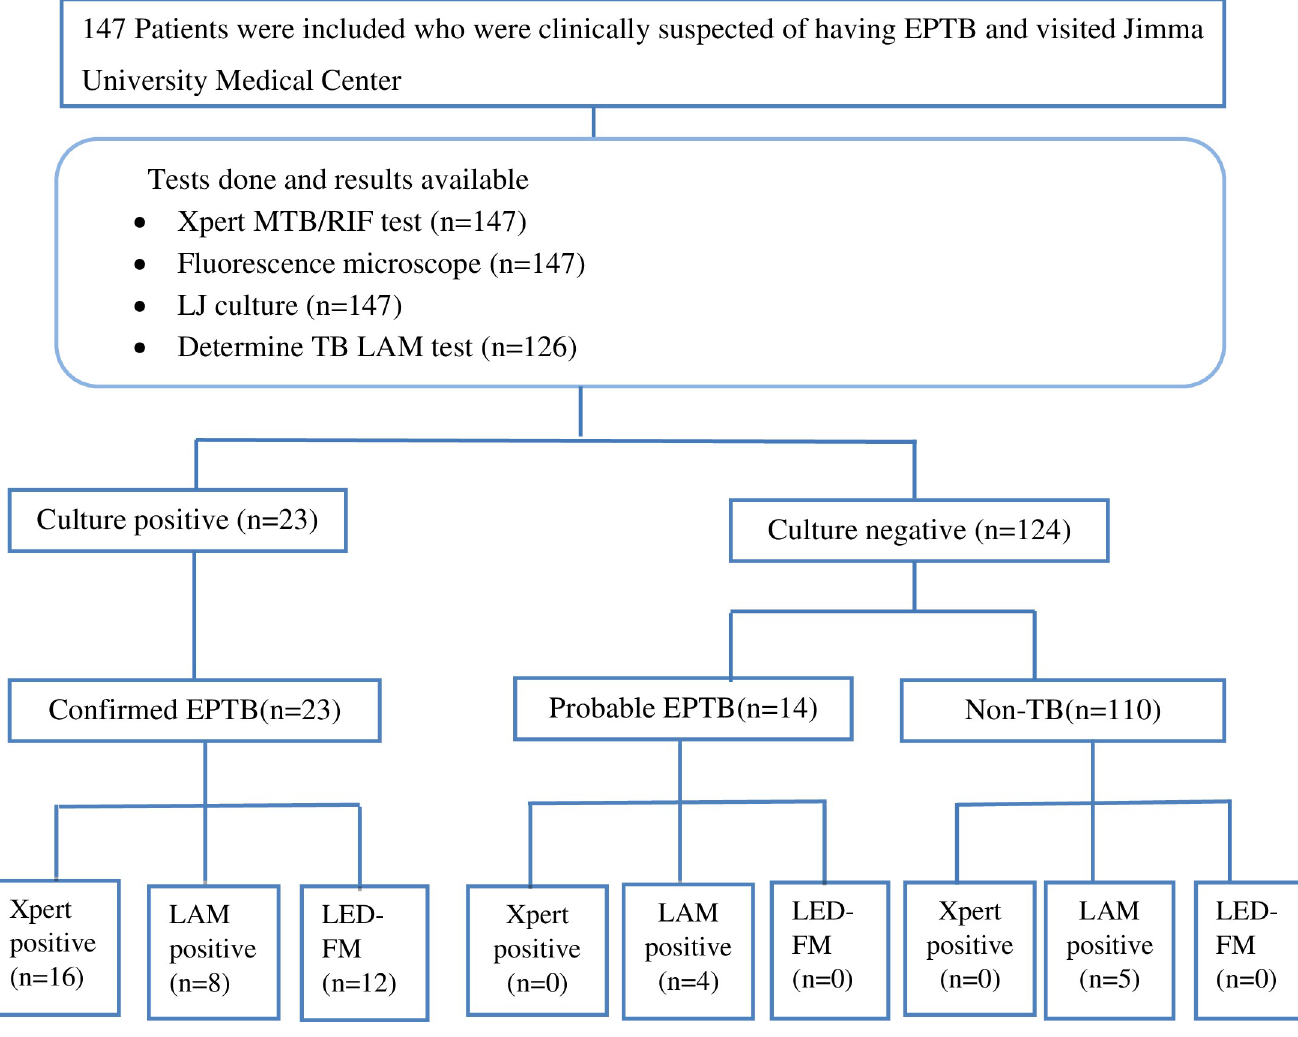
Fig 1. Flow chart showing overall patient flows, diagnostic test result and diagnostic classifications. cases had various sites affected, including meningitis, lymph node, skin, and pericardial. How- ever, TB disease detection (confirmed cases) rate was highest among patients suspected of hav- ing lymph node TB (56.5%) followed by pleura TB (17.4%) and TB meningitis (13%). Bacteriologically confirmed EPTB was found in 23 of the presumptive EPTB cases, for a detection rate of definite EPTB of 15.6% (95% CI: 10.2%, 22.5%). Of these, 13 had lymph node TB, 4 had TB pleuritis, 3 had TB meningitis and 2 had peritoneal TB ( Table 1 ). One TB case was identified from gastric aspirate from whom pulmonary manifestation was excluded ( Table 1 ). Among 23 culture-positive EPTB cases, 16 (69.6%) were Xpert MTB/RIF positive, with no rifampicin resistance detected and 8 (34.8%) were positive for AFB by fluorescent microscopy. Furthermore, there were 14 (11.3%) patients with probable TB- cases with clinical improvement after clinician’s decision to start ATT whereas 110 patients were classified as ‘non TB’ cases because no bacteriological or clinical evidence for TB was observed ( Fig 1 ). The combined detection rate of definite and probable EPTB was 25.2% (95% CI: 18.4–33.0); 37/ 147. Compared to CRS (definite and probable EPTB cases), L-J culture had a sensitivity of